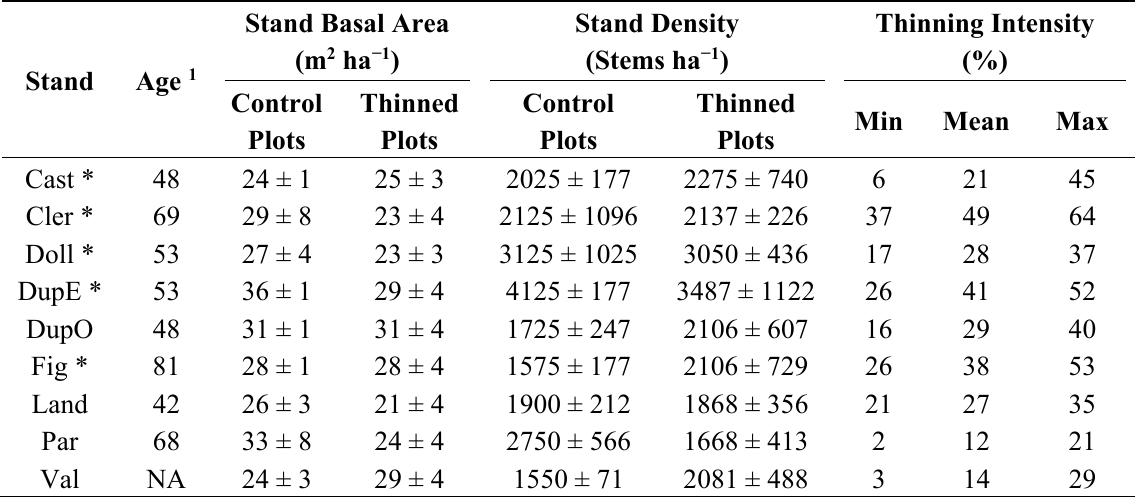
Table 1. Initial characteristics of nine jack pine stands subjected to a range of commercial thinning intensities. Average values and standard errors of two 200 m 2 in permanent sampling plots in control experimental units and eight plots in thinned experimental